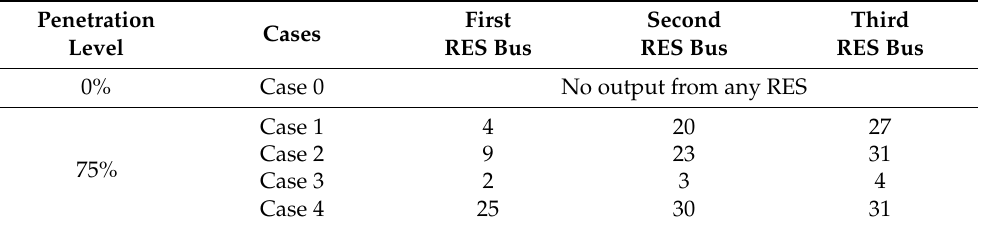
Table 2. RES placement for different cases of the second strategy.